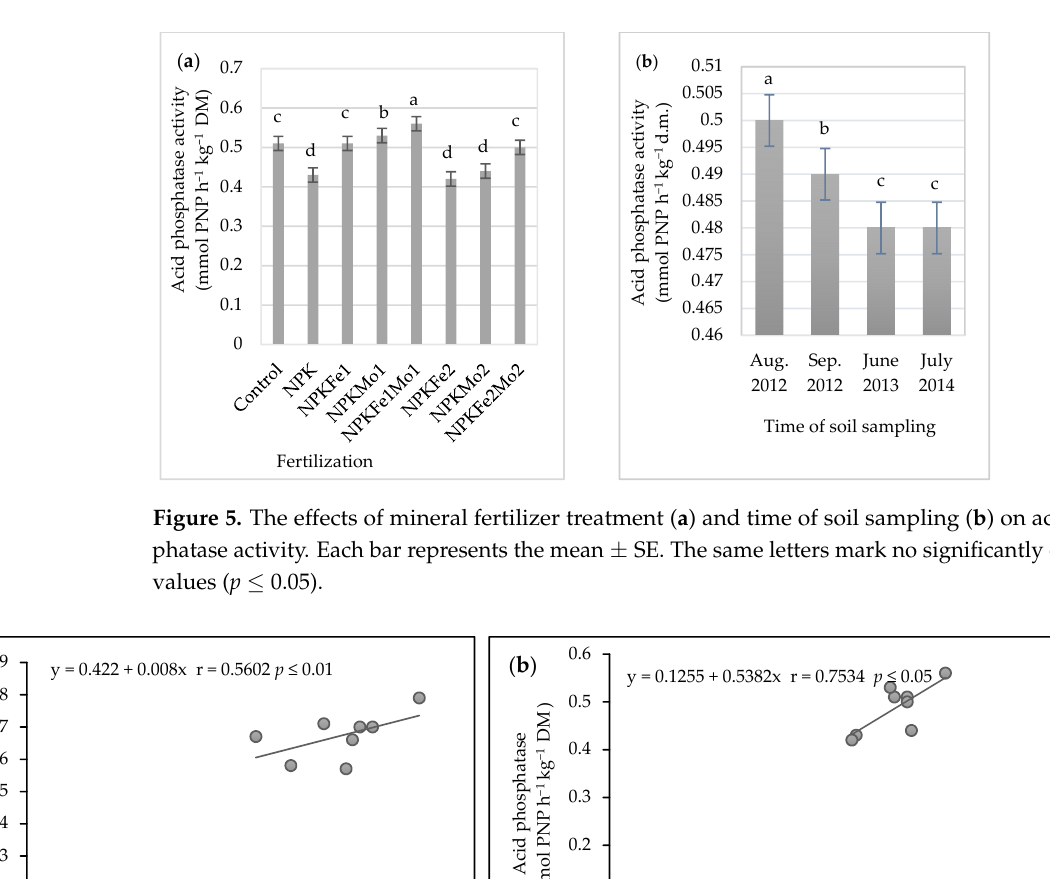
Figure 5. The effects of mineral fertilizer treatment ( a ) and time of soil sampling ( b ) on acid phos- phatase activity. Each bar represents the mean ± SE. The same letters mark no significantly differ- ent values ( p ≤ 0.05).